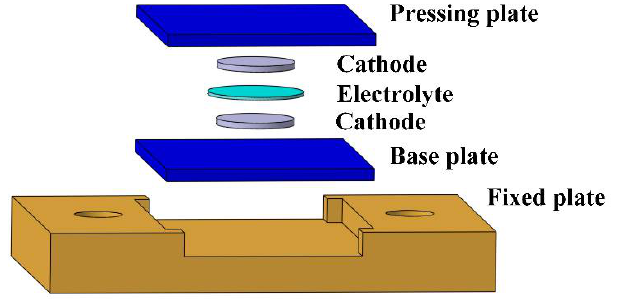
Figure 1. The ultrasonic fusion